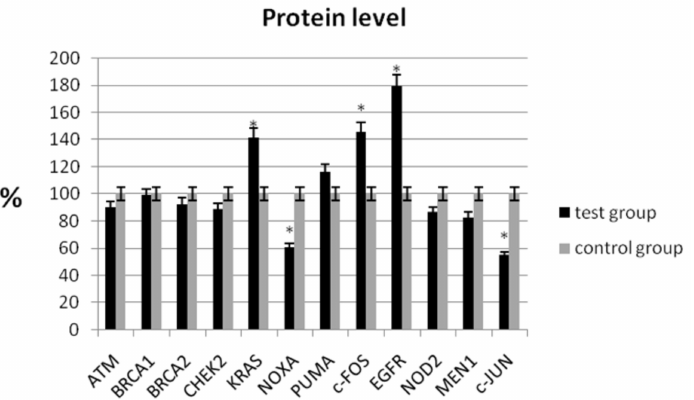
Figure 2. Analysis of protein level of selected genes in patients with ovarian cancer compared with the control group. The control group was defined as 100%. Data are presented as mean% ± SD, * p < 0.05 compared with the control